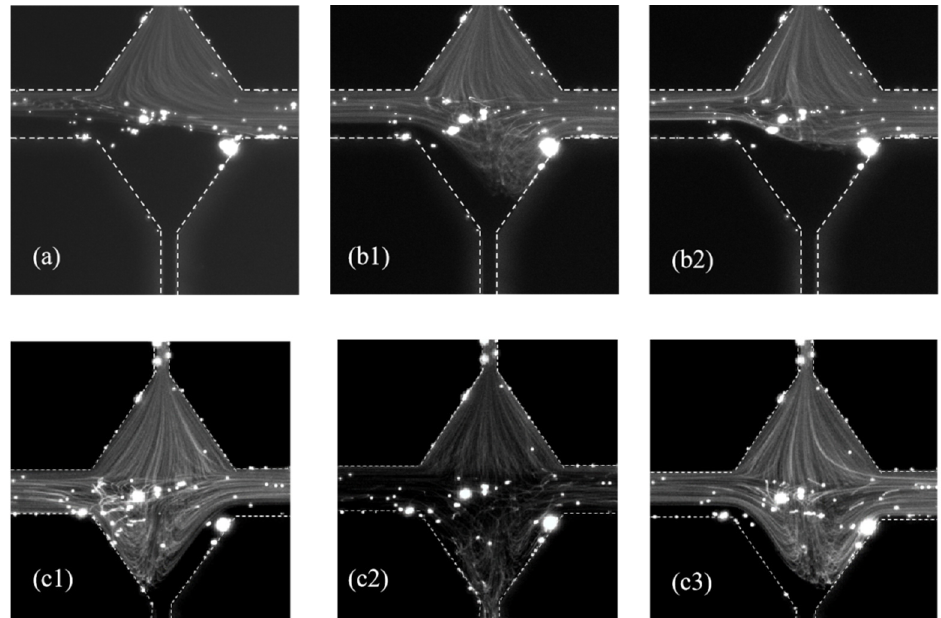
Figure 8. PAM flow pattern in the RCM with fixed Q upper at 3000 µ L/hour but different Q lower : ( a ) Q lower = 2000 µ L/hour, ( b1 , b2 ) Q lower = 500 µ L/hour, and ( c1 – c3 ) Q lower = 200 µ L/hour.